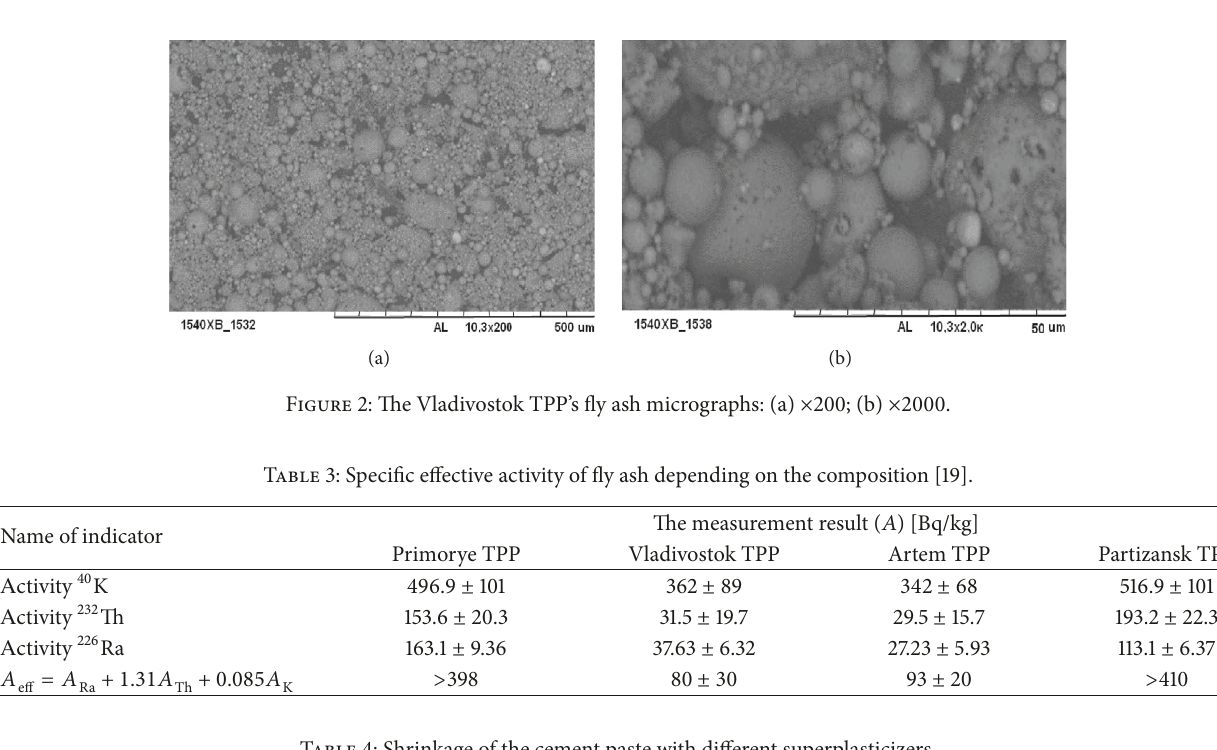
Table 4: Shrinkage of the cement paste with different superplasticizers.